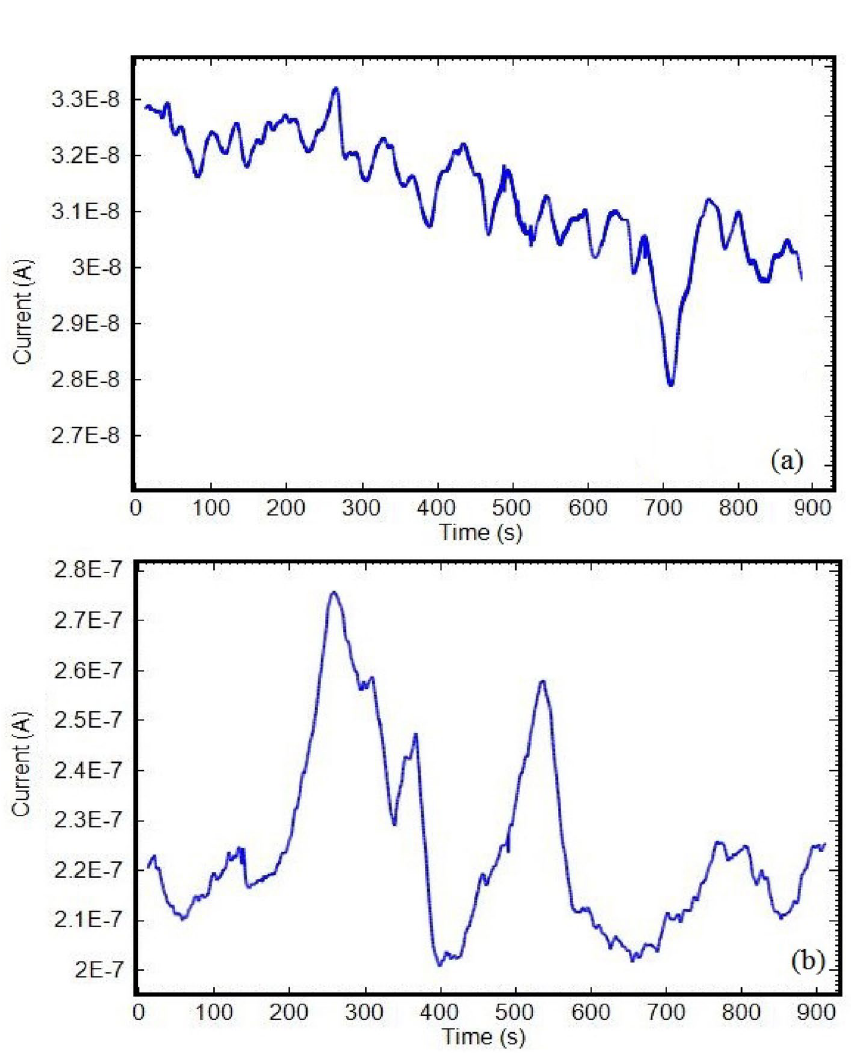
Figure 9. The original ECN signals of Asy electrodes in 0.3 M NaCl + 0.3 M Na 2 SO 4 solution at ( a ) 40 °C and ( b ) 80